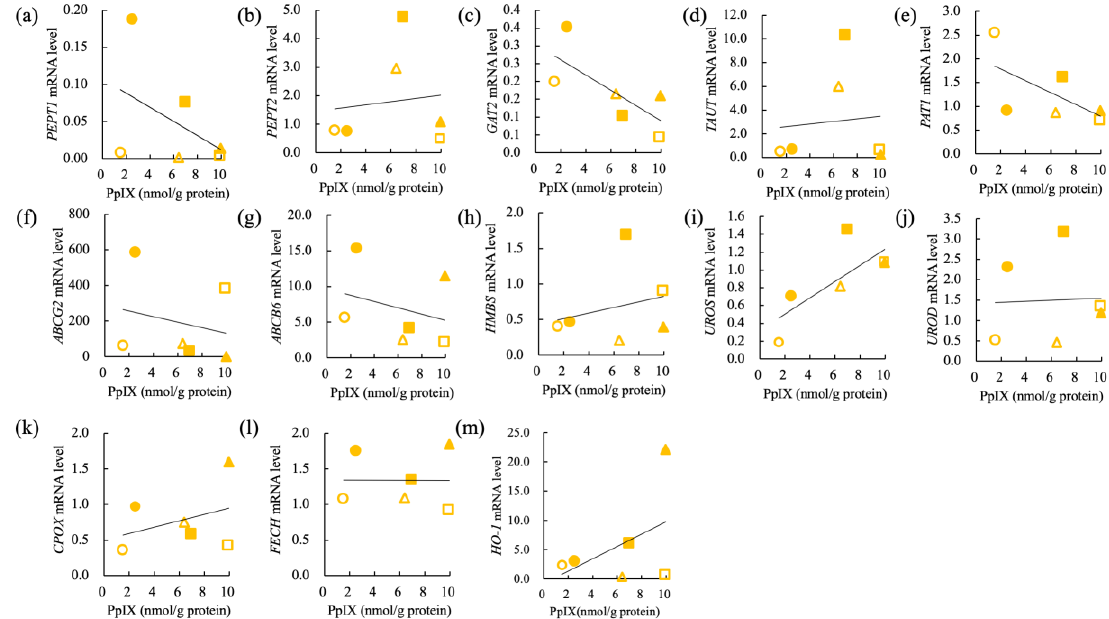
Figure 10. Correlation of intracellular PpIX concentration and relative mRNA levels in sarcomas. ( a ) Peptide transporter 1 (PEPT1), ( b ) peptide transporter 2 (PEPT2), ( c ) GABA transporter 2